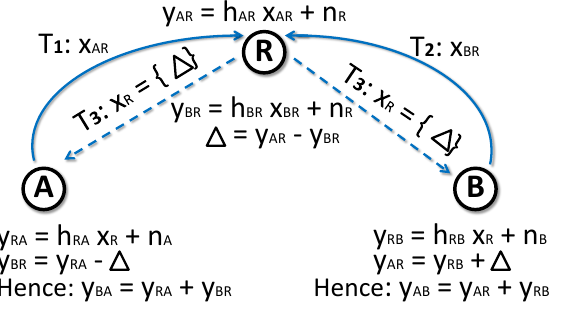
Figure 4: Proposed protocol for secret key genera- tion leveraging NC scheme.